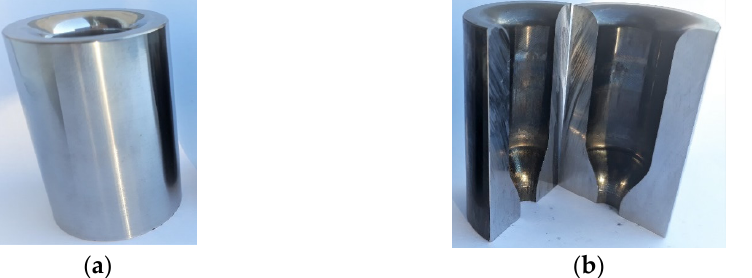
Figure 1. Selected dies used in the first operation (preliminary forging) of forging process of valve forgings: ( a ) new tool; ( b ) removed from production with visible wear.